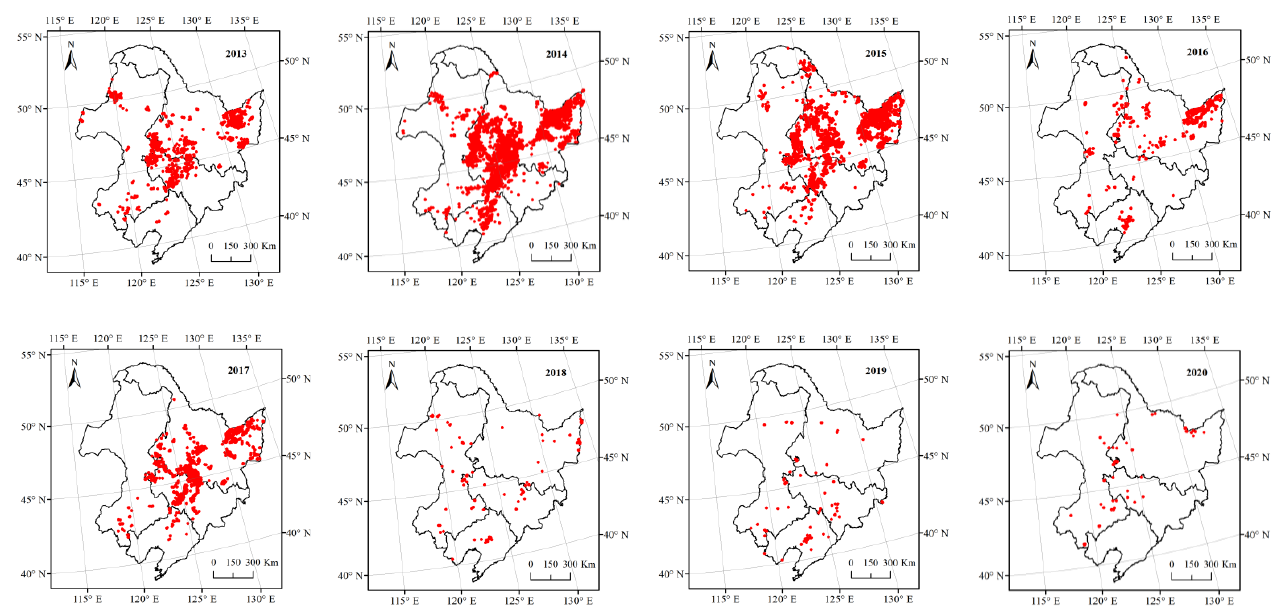
Figure 2. Spatial distribution of fire points in Northeastern China by MODIS observations from 2013 – 2020.